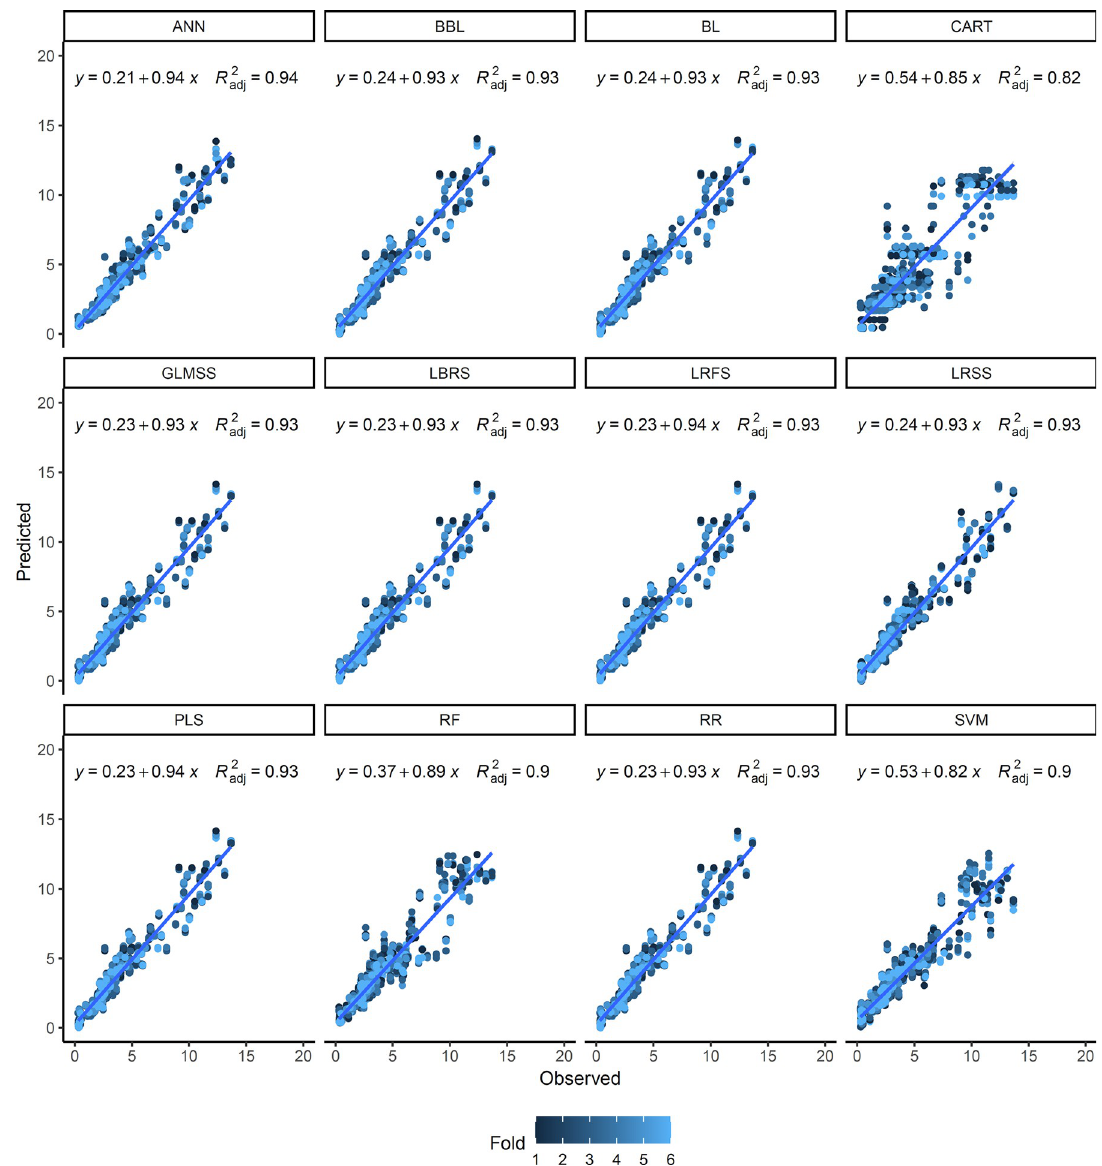
Fig 6. Relationship between observed and predicted values for total carotenoid content of cassava roots. The prediction was performed based on 12 different models based on random cross-validation without test set (V-Random) (80/20% in training and validation, respectively). Artificial neural network (ANN), Bayesian Blasso (BBL), Bayesian Lasso (BL), classification and regression trees (CART), generalized linear model with stepwise feature selection (GLMSS), linear regression with backward selection (LRBS), linear regression with forward selection (LRFS), linear regression with stepwise selection (LRSS), partial least squares (PLS), random forest (RF), ridge regression (RR), and support vector machine (SVM) were calculated. Each cross-validation fold is represented in different colors. The numerical data included in the graphs represent: linear equations (y) and coefficient of determination (R 2